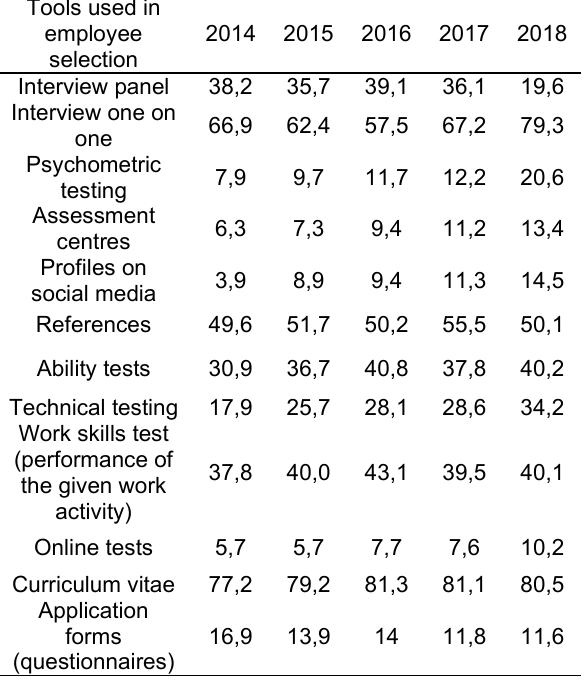
Table 4. Tools used in employee selection (source: